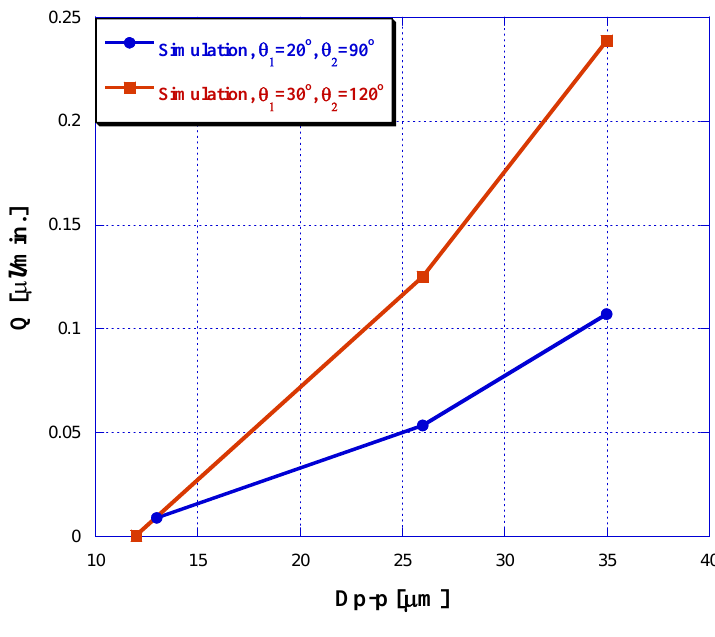
Figure 6. Chart of different driving pressures with θ = θ 2